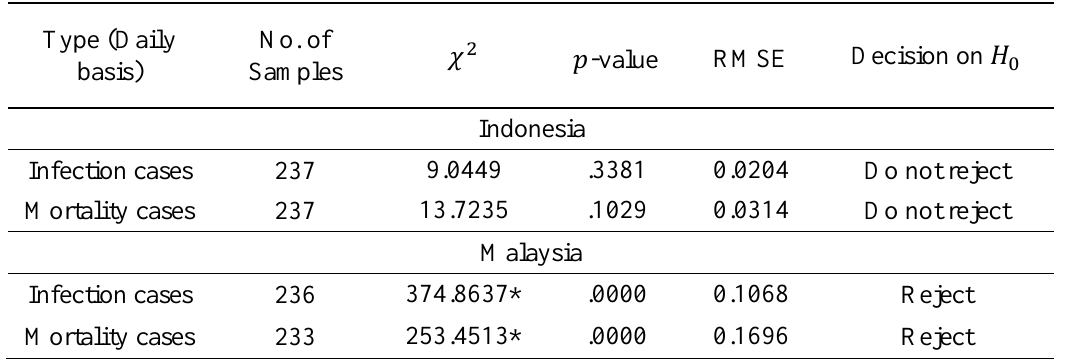
Table 1. Statistics of the daily infection and death cases. Note. *Observed distribution is significantly different from NBL ( <